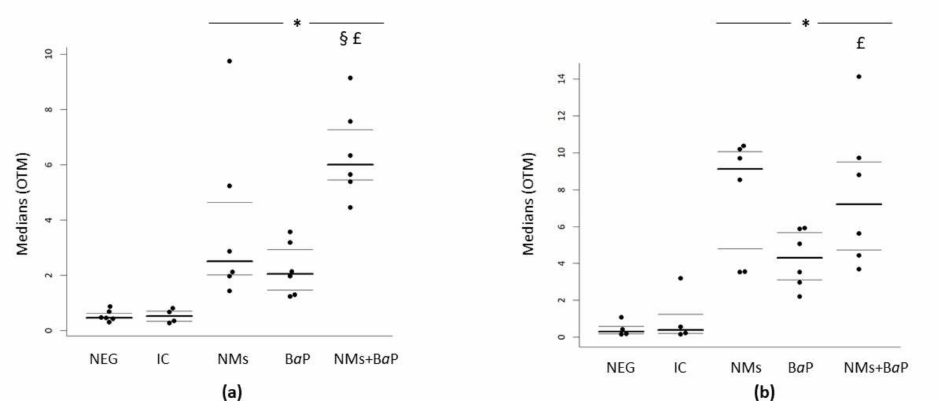
Figure 2. Evaluation of DNA damage using the comet assay following in vitro exposure of rat cumulus cells ( a ) and oocytes ( b ) to NMs+B a P. Tested concentrations: negative control = Ferticult ® medium, IC = intern control (Ferticult ® 1% S9 mix, 1% DMSO), NMs: aged CeO 2 NMs at 1 µ g · L − 1 ; B a P: B a P at 1.13 µ mol · L − 1 ; NMs+B a P: aged CeO 2 NMs at 1 µ g · L − 1 previously incubated with 1.13 µ mol · L − 1 B a P. p < 0.05, for differences compared versus *: negative control (NEG); §: vs. NMs, £: vs. B a